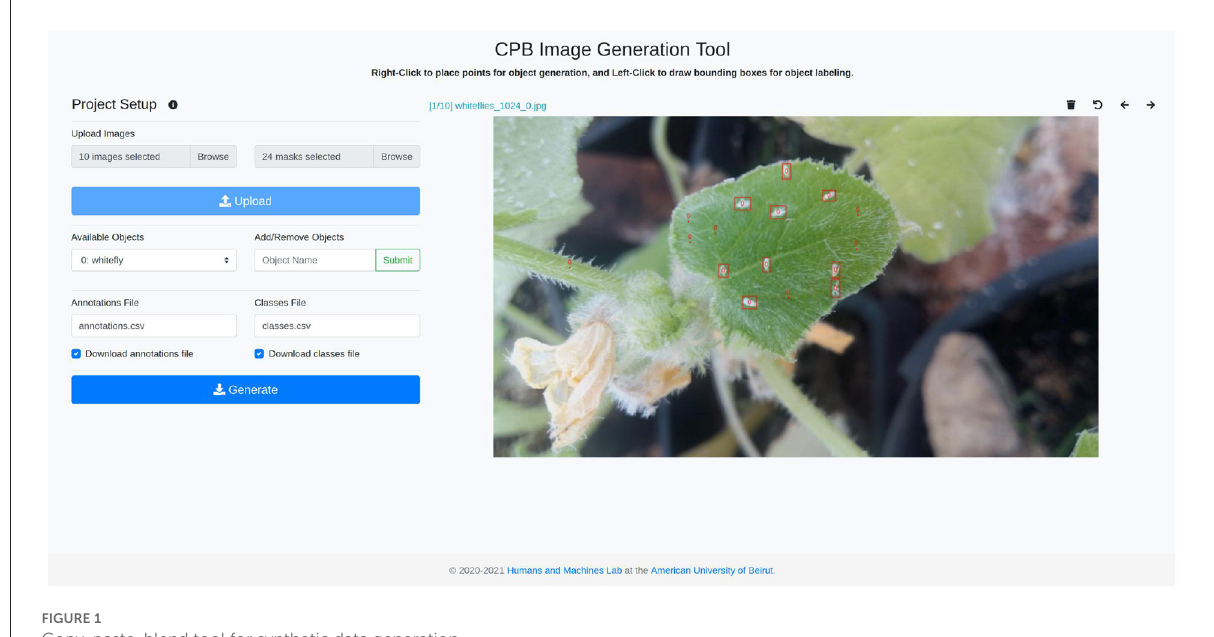
FIGURE1 Copy-paste-blend tool for synthetic data generation.